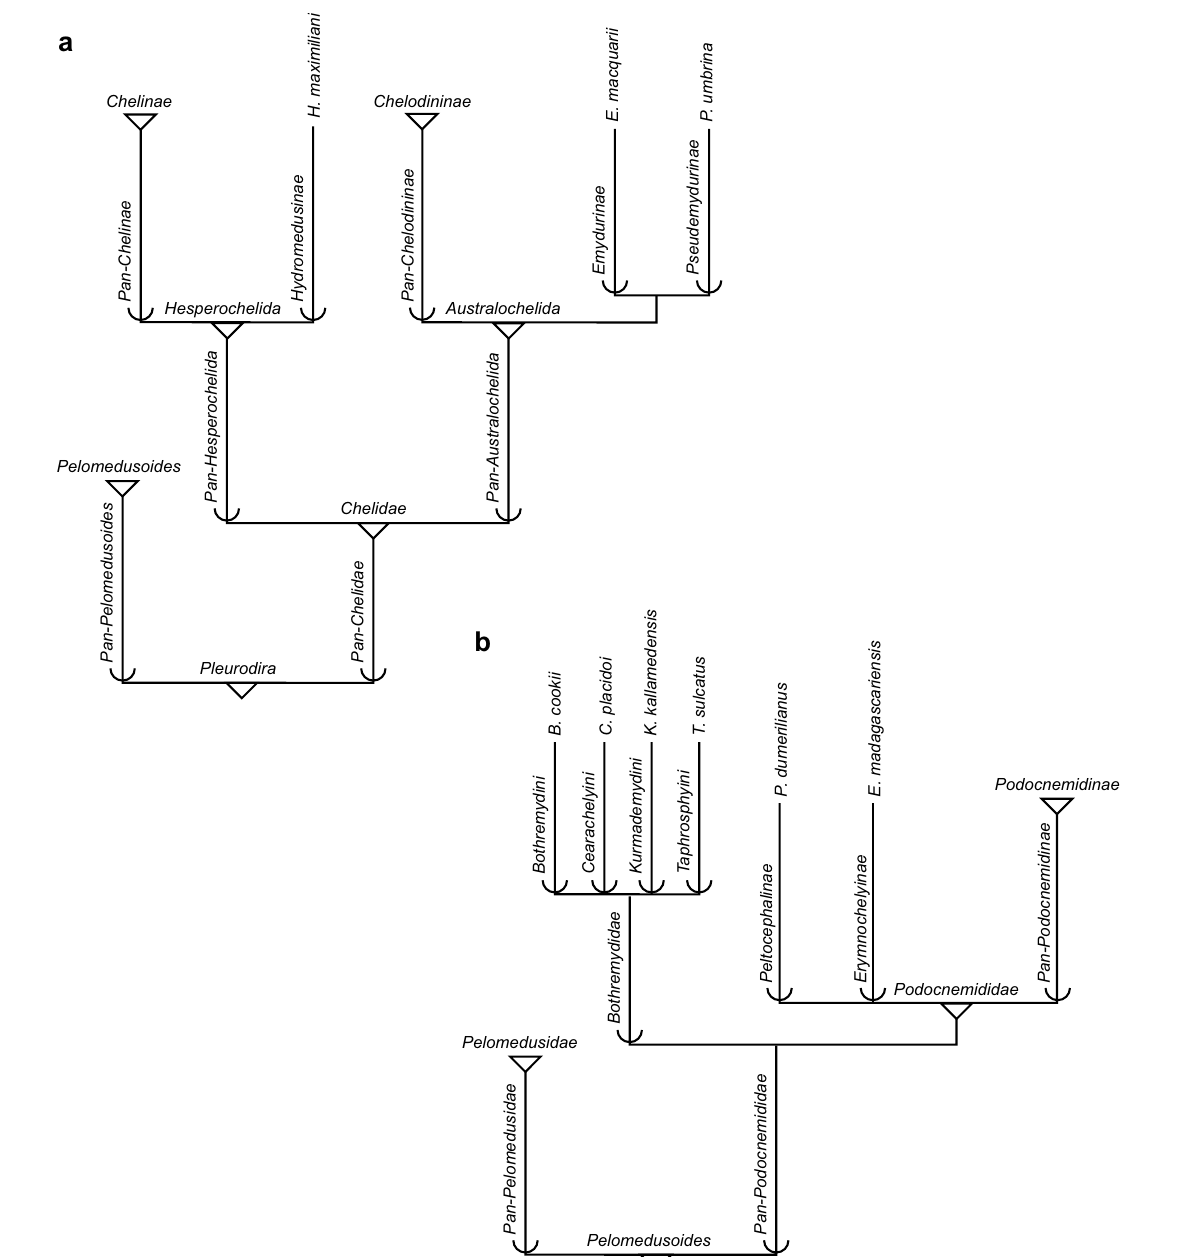
Fig. 2 Simplified diagrams that highlight the proposed name usage of clade names within a Pleurodira and b